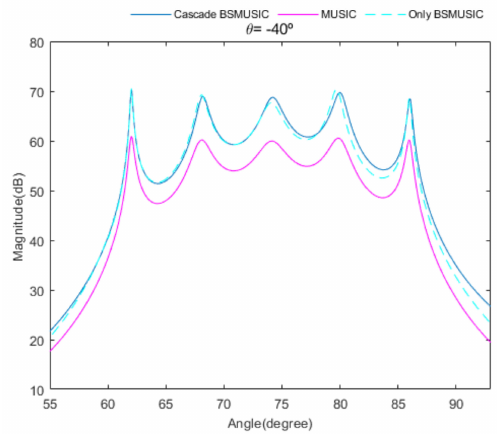
Figure 14. Comparison of the proposed cascade algorithm, MUSIC, and only Beamspace MUSIC, for the second scenario.